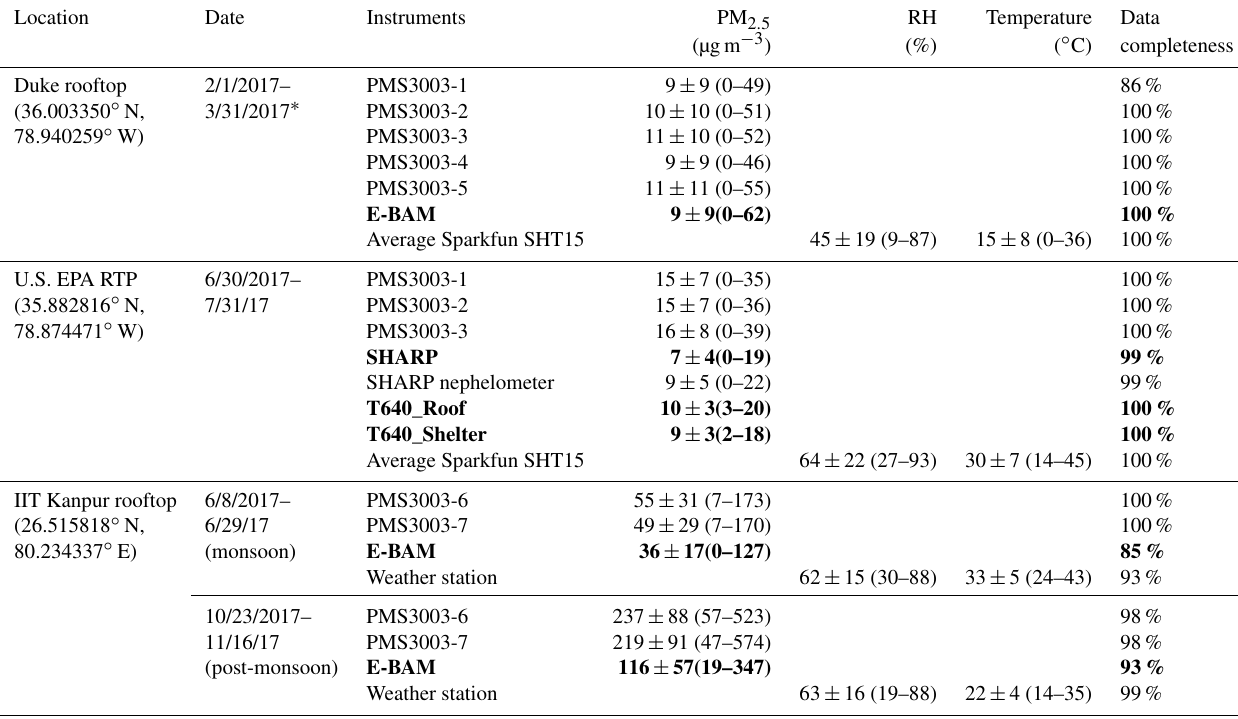
Table 1. Summary statistics for 1h averaged measurements (mean ± SD (range)) at the three sampling locations. Reference monitors at the sampling locations are indicated with bold font. The dates are formatted